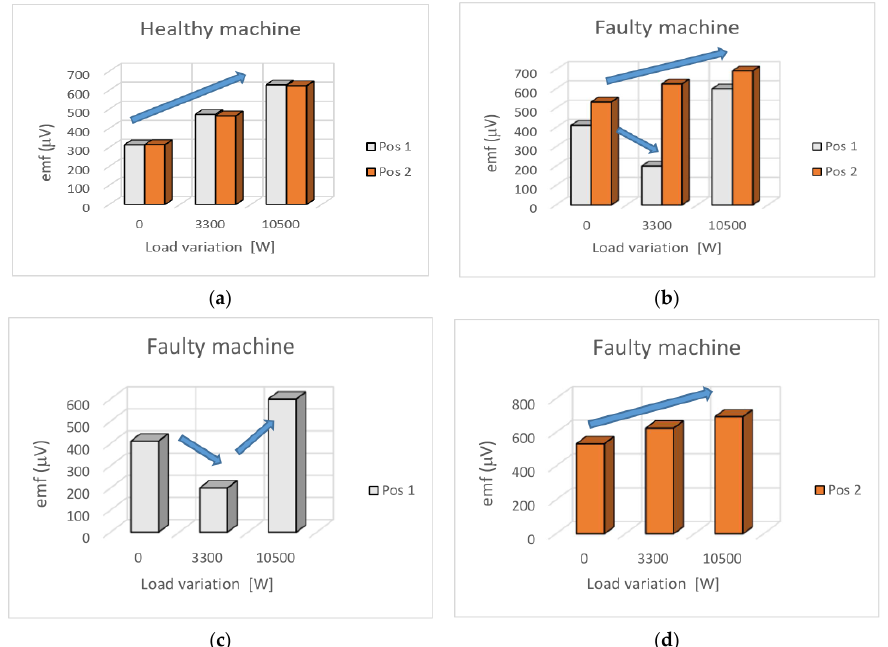
Figure 12. Harmonic components at 850 Hz under both measurement positions for generator operating at load variation in healthy and faulty case: ( a ) healthy case, ( b ) faulty case, ( c ) variation in faulty case for measurement in position 1, ( d ) variation in the faulty case for measurement in position 2.